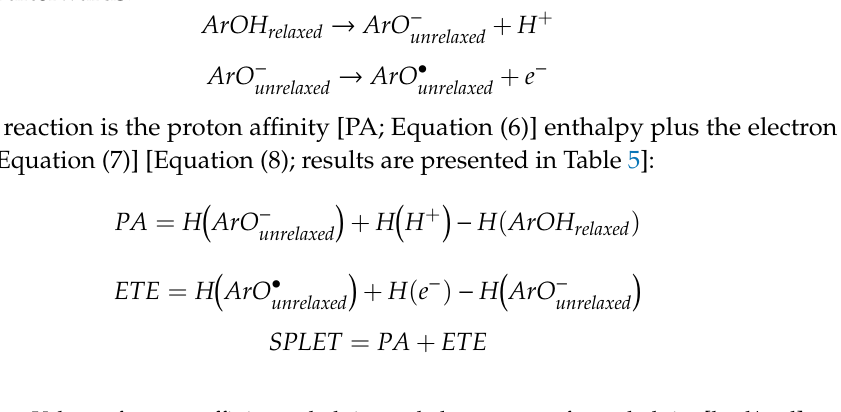
Table 5. Values of proton a ffi nity enthalpies and electron transfer enthalpies [kcal / mol].